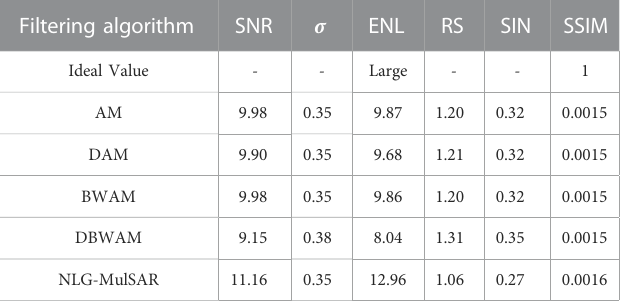
TABLE 2 Objective evaluation datatable of different fi ltering algorithms for ratio